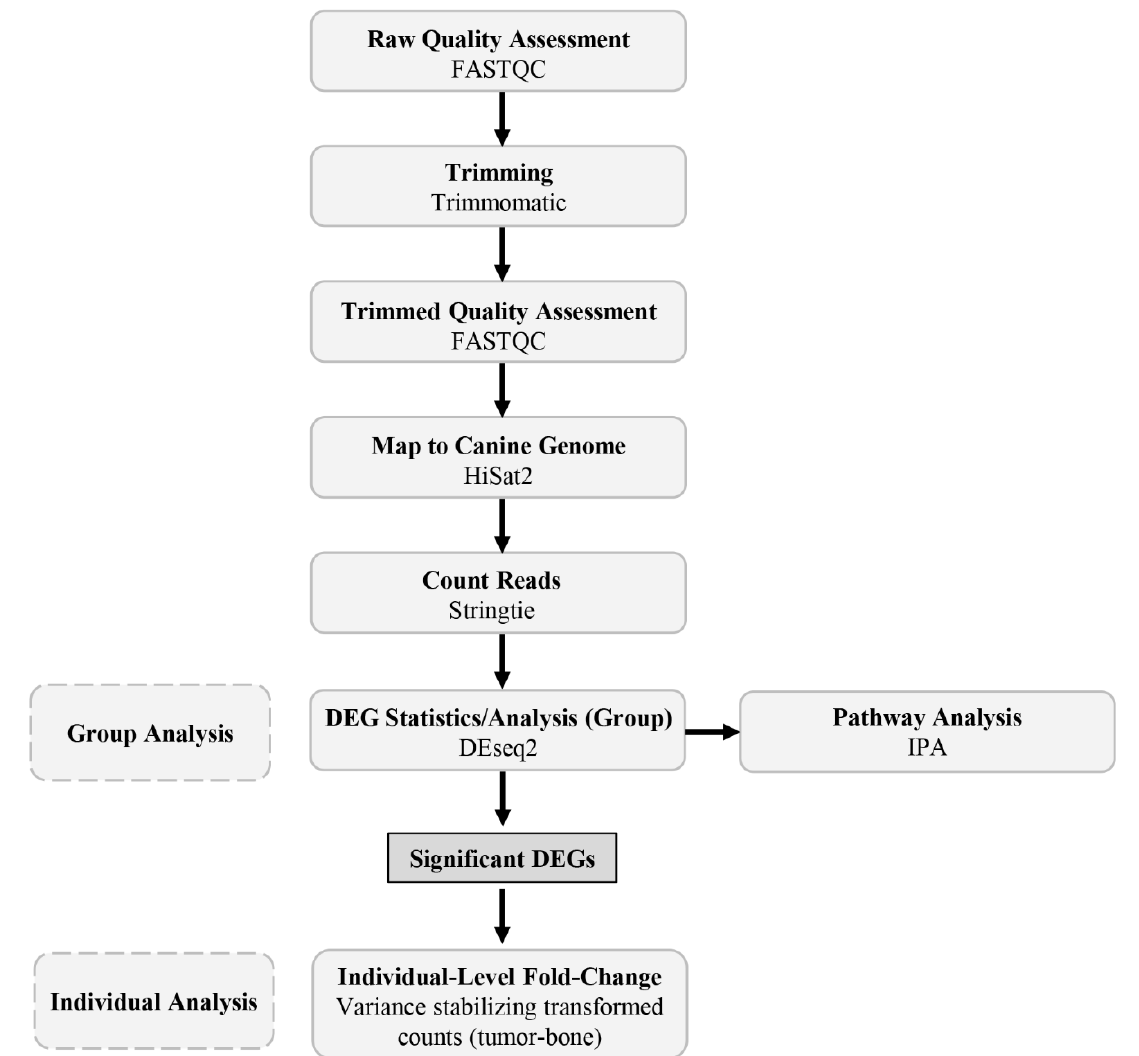
Figure 1. Overview of bioinformatic pipeline used to process and analyze data. RNA sequence data were subjected to modest trimming with Trimmomatic and quality analysis with FASTQC prior to mapping to the reference canine genome with HiSat2, counting reads with Stringtie, and DEG statistics with DEseq2 to generate significant DEGs (FDR < 0.05, FC > 2, ≤2) which were carried forward in pathway and individual analyses. Using the significant DEGs from the group analysis, fold-change values were generated for each patient to produce the individual-level data. Bioinformatic tools and packages utilized are indicated.